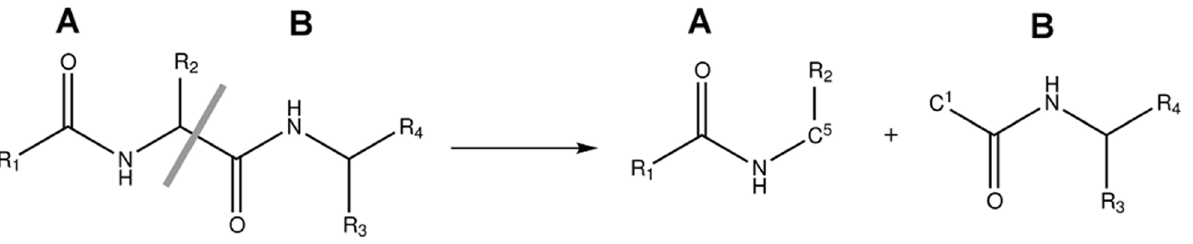
Figure 3. Cross region fragmentation. The fragmentation procedure shares an atom (here C 1 and C 5 is the shared atom) between two neighboring and covalently bonded fragments. Even though these fragments are in separate regions, they still share an atom across that region as illustrated.